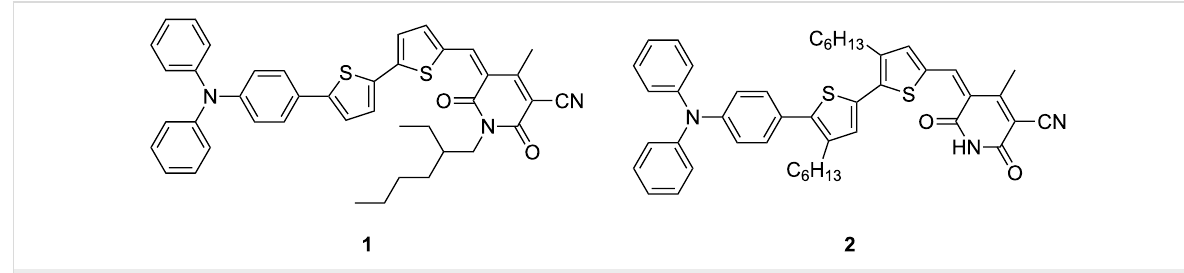
Figure 1: N -ethylhexyl-substituted ( 1 ) [20] and target free N–H ( 2 ) cyanopyridone structures.